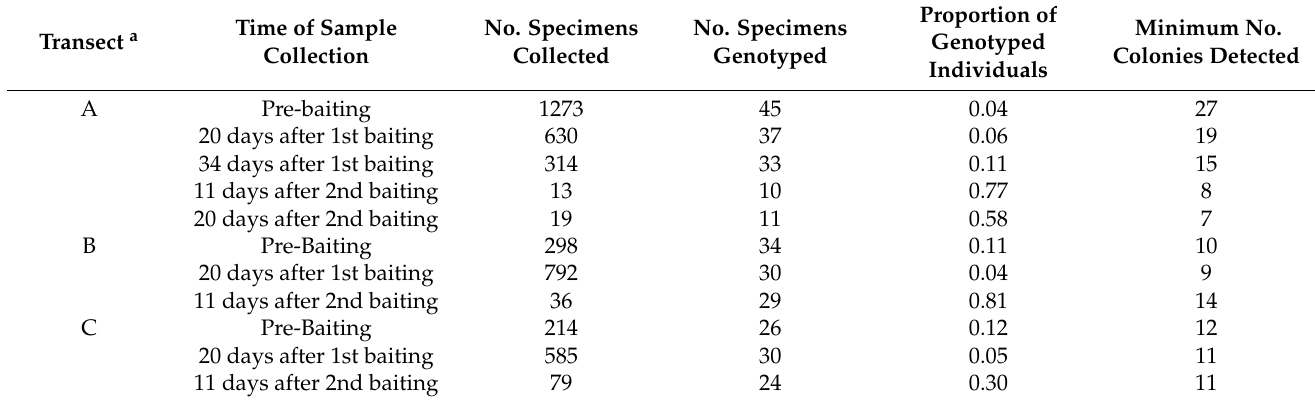
Table 6. Analysis of yellowjackets at transects A–C with an estimate of the minimum number of different colonies in 2020 at Richmond Field